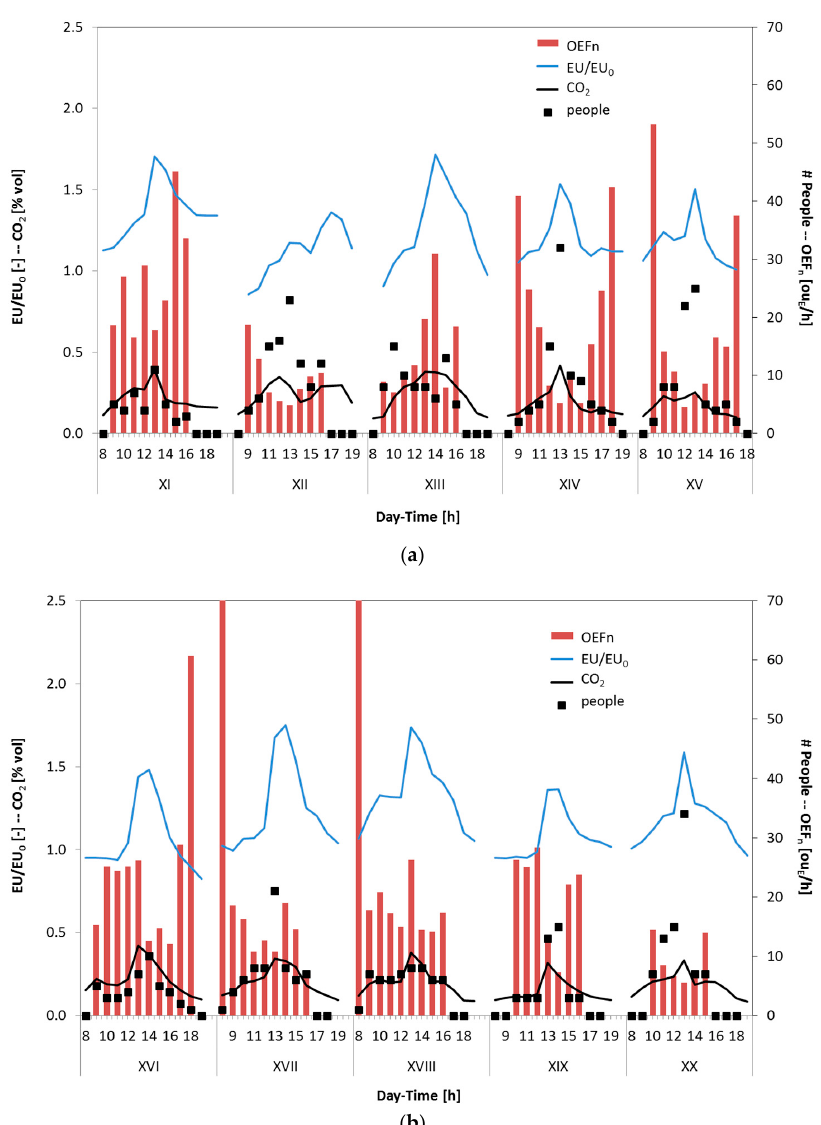
Figure 6. Trends of EU/EU 0 , CO 2 concentration, number of occupants and estimated OEF n for the period from day XI to XV ( a ); and for the period from day XVI to XX ( b ).